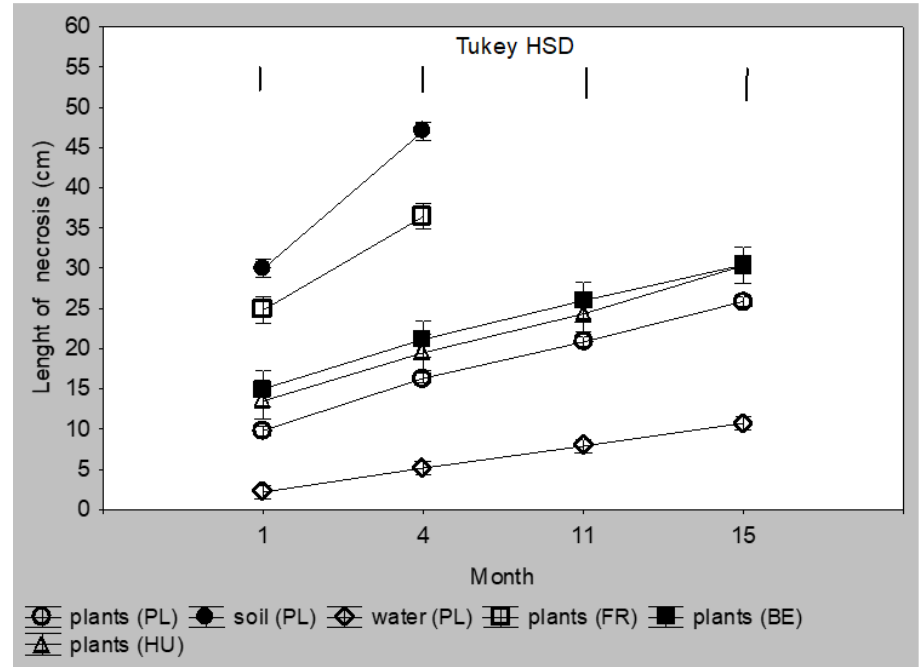
Figure 4. Colonization of Alnus glutinosa shoots planted as 2-year-old seedlings in a substrate infected with Phytophthora × alni ( n = 12). Vertical bars at means showing SD. Tukey HSD—honestly significant difference calculated according to Tukey test at p = 0.05 for comparisons of the isolates group at each term of measurements.